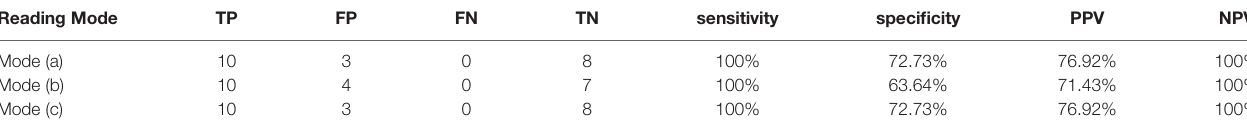
TABLE 3 | The diagnostic values of the synthesized FP-Dyn sequences for breast lesions. Reading Mode